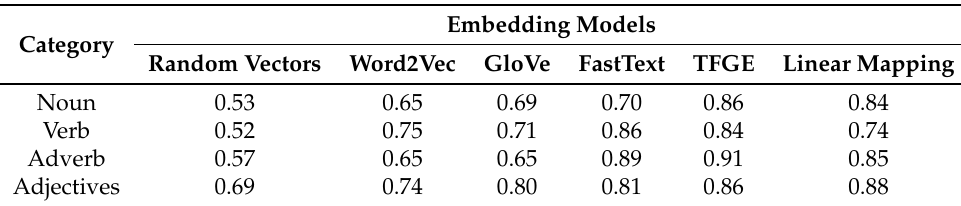
Table 9. Category-based accuracy for Deep Learned POS Tagger trained on different embedding models and Linear Mapping on